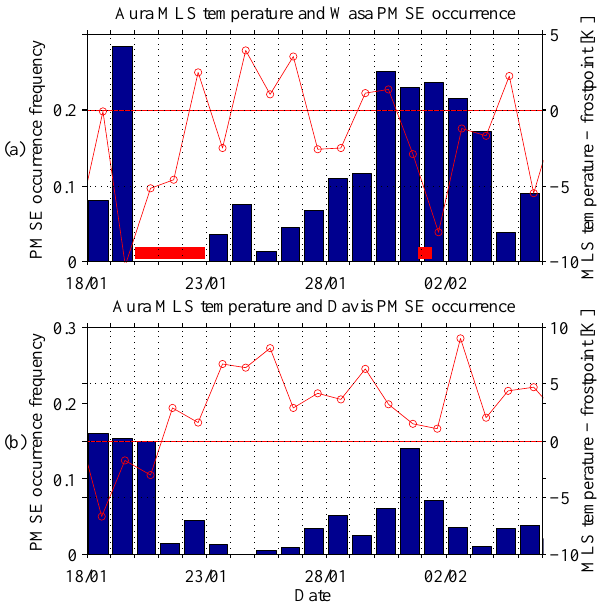
Fig. 1. Occurrence frequency of PMSE for each day for Wasa (top Fig.1. OccurrencefrequencyofPMSEforeachdayforWasa(toppanel)andDavis(bottompanel),lefty-axis. panel) and Davis (bottom panel), left y-axis. Data between 80 and Databetween80and90 kmwereused. PeriodswhentheMARAradaratWasawasnotoperatingareindicated 90km were used. Periods when the MARA radar at Wasa was not bythickhorizontalredlines. ThetemperatureminusthefrostpointasestimatedfromAuraMLSmeasurements areshownwithredlines,righty-axis. operating are indicated by thick horizontal red lines. The temper- ature minus the frostpoint as estimated from Aura MLS measure- ments are shown with red lines, right